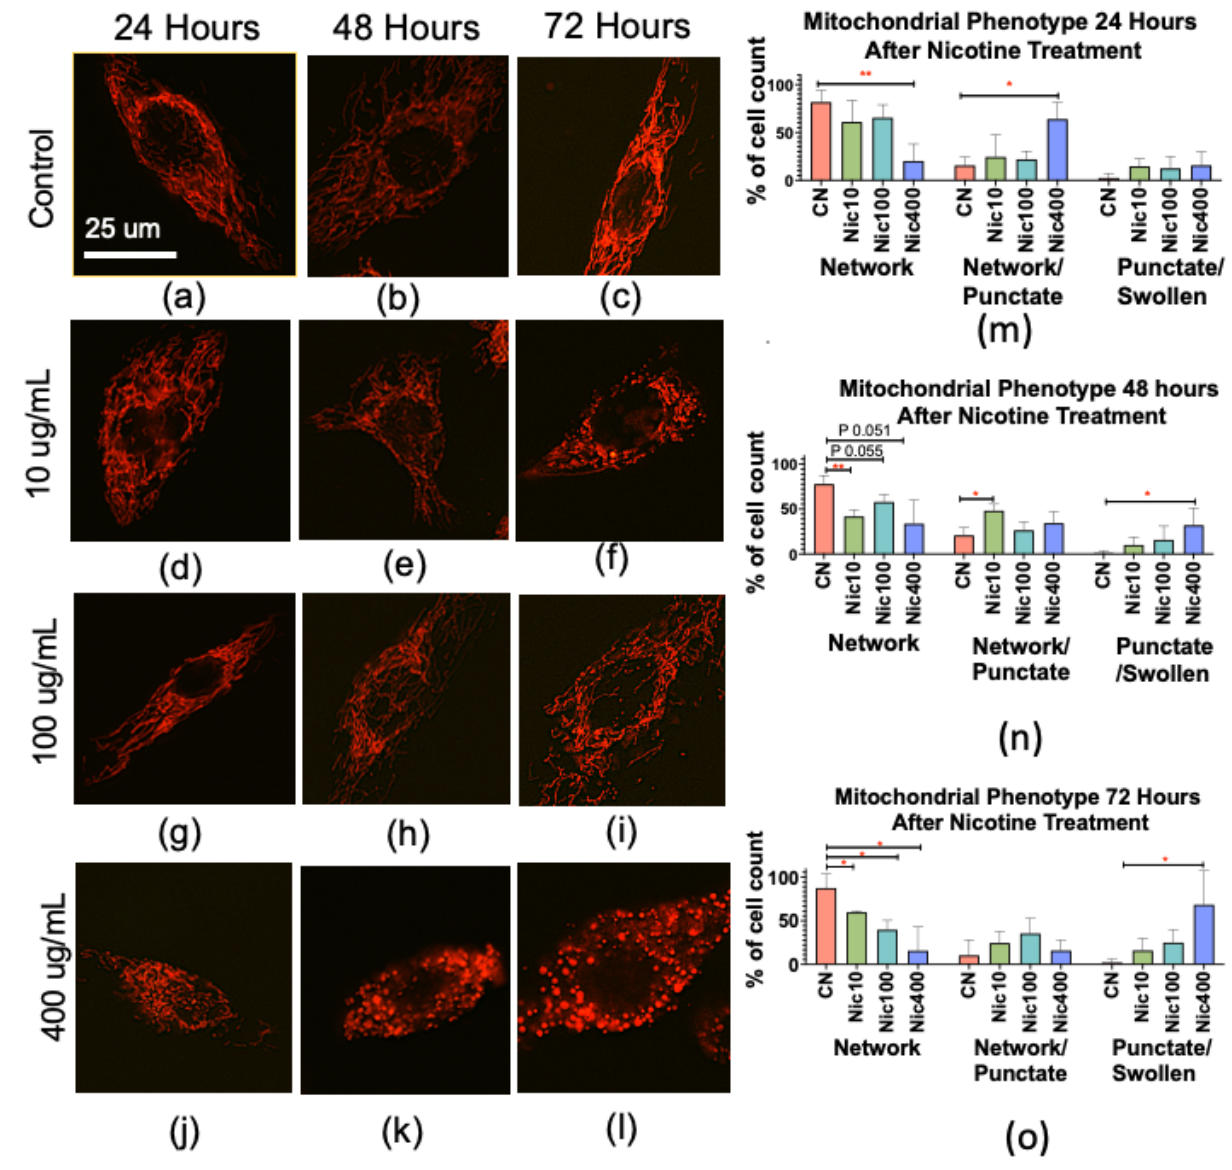
Figure 2. Mitochondria in keratinocytes treated with Nic10, Nic100, or Nic400 for 24, 48, or 72 h. ( a – l ) Micrographs of mitochondria treated with various concentrations of nicotine and imaged at different times; ( m ) mitochondrial morphology 24 h after nicotine treatment; ( n ) mitochondrial morphology 48 h after nicotine treatment; ( o ) mitochondrial morphology 72 h after nicotine treatment. CN = control medium. All data are means ± the standard error of the mean for three independent experiments. * = p < 0.05, ** = p <